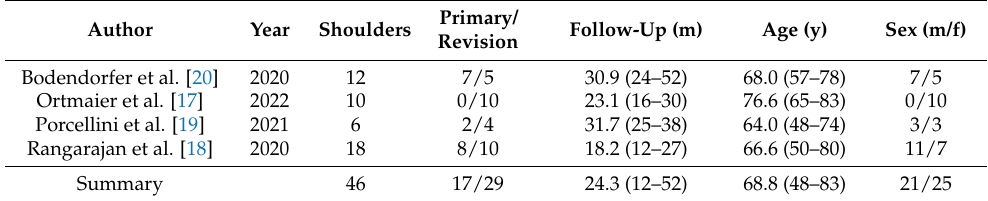
Table 1. Studies reporting short-term outcome of custom glenoid implants—patient demographics of the included studies a